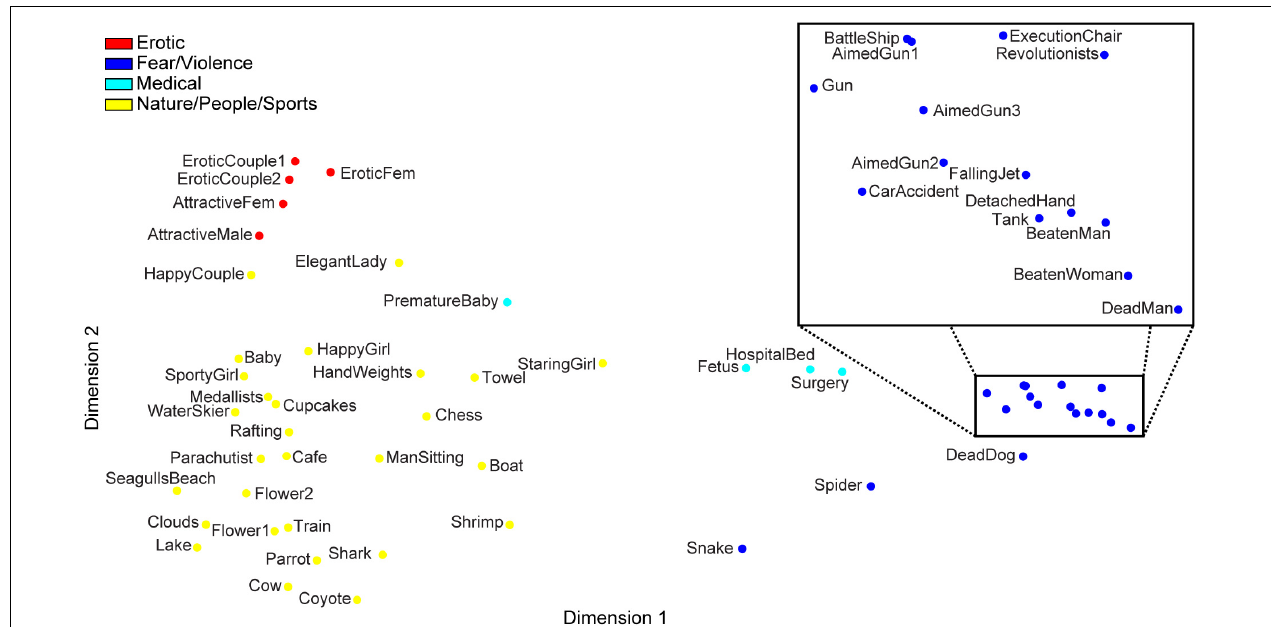
FIGURE 2 | The 54 IAPS stimuli used in the experiment plotted in a two-dimensional space obtained from classical multidimensional scaling of the group-median affective space. The clusters are color-coded according to the 4-cluster solution from the hierarchical clustering (see Figure 1 ). The 2-cluster solution simply incorporates the cool colors into one cluster and the warm colors into the other.